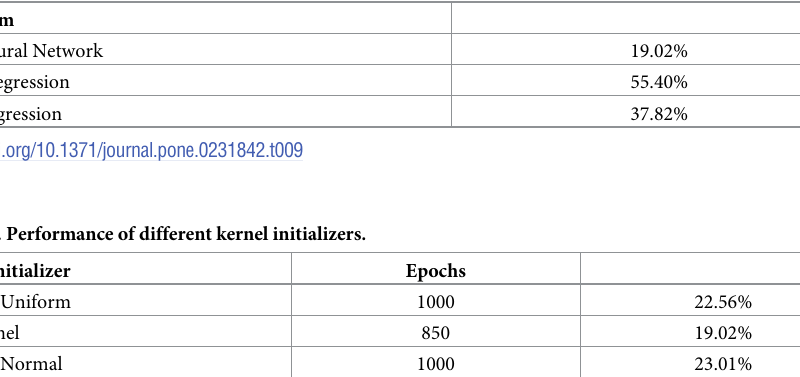
Table 9. Mean Absolute Percentage Error(MAPE) for different regression algorithms.